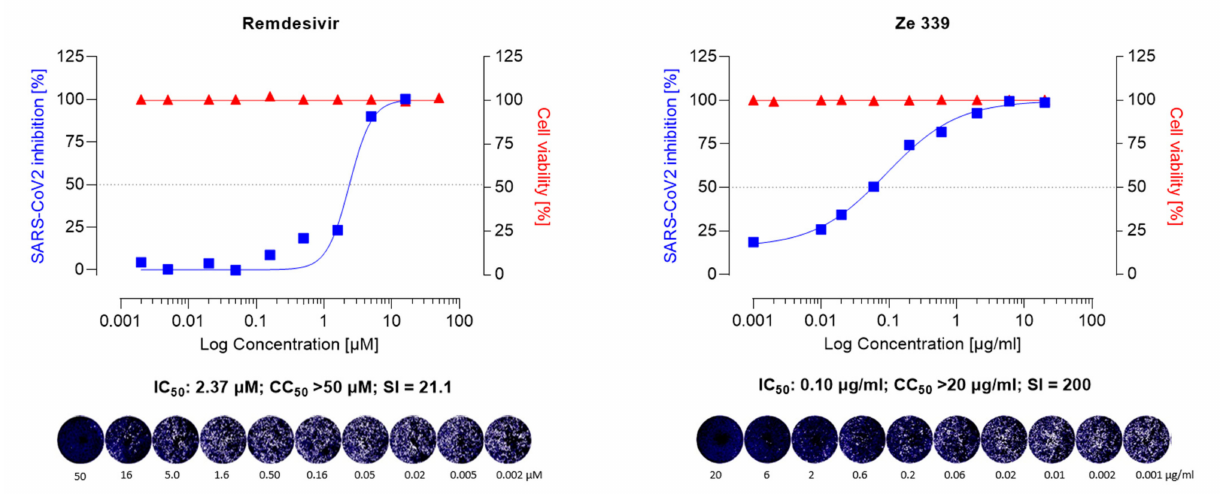
Figure 2. Anti-SARS-CoV-2 activity of the remdesivir and Ze 339 in VeroE6 cells was assessed using the Wuhan strain of SARS-CoV-2. Cells were infected with 100 pfu of a clinical virus isolate in the presence of the indicated concentrations. Blue squares represent inhibition of SARS-CoV-2 infection (%) and red triangles represent cell viability (%). Data are expressed as the mean of two replicates (infection performed in duplicate) with their respected 95% confidence interval. Remdesivir 95% confidence interval = 0.25–0.51, goodness of fit = 0.9668; Ze 339 95% confidence interval = 0.06–0.12, goodness of fit =